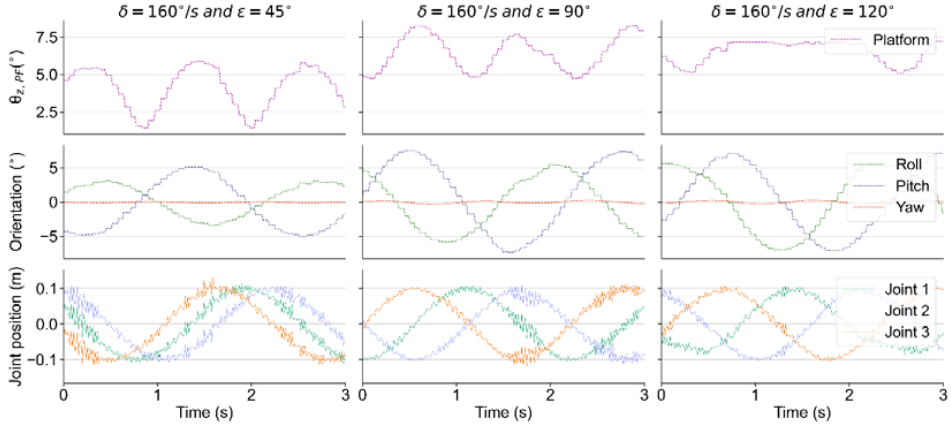
Figure 4. The variation in the tilt angle and Euler angle of the bench, and the displacement of the prismatic joints. During the training process, the phase interval is 100 °